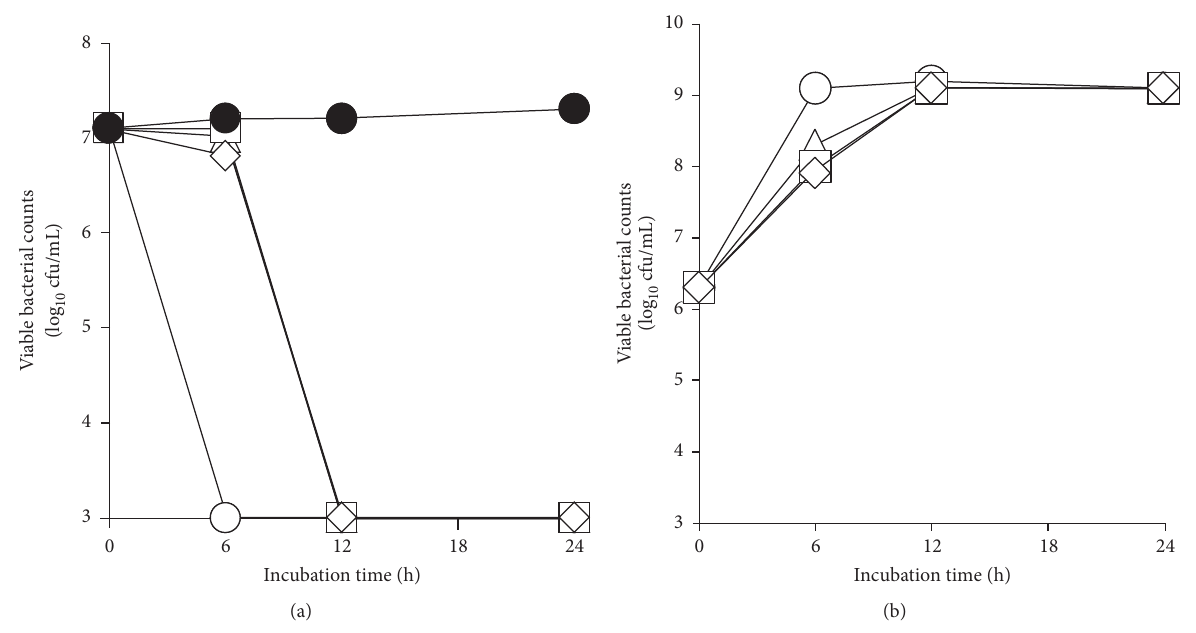
Figure 1: Viable counts of P. gingivalis ATCC 33277 in the presence or absence of each of the four lactic acid bacteria (a) and viable counts of lactic acid bacteria in mixed culture with P. gingivalis ATCC 33277 (b). e : number of P. gingivalis ATCC 33277 in monoculture, I : number of P. gingivalis ATCC 33277 or E. faecium WB2000 in mixed cultures, △ : number of P. gingivalis ATCC 33277 or L. salivarius CIP 103140 in mixed cultures, ◻ : number of P. gingivalis ATCC 33277 or L. reuteri JCM 1112 in mixed cultures, and ⬦ : number of P. gingivalis ATCC 33277 or S. salivarius JCM 5707 in mixed cultures.